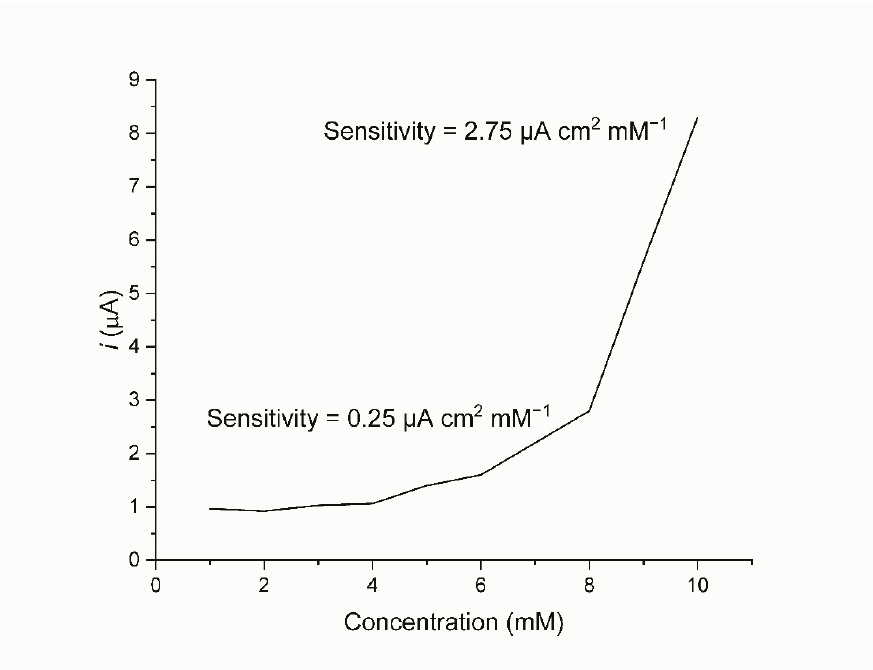
Figure 11. Calibration curve of the current verses different glucose concentrations (1 to 10 mM).